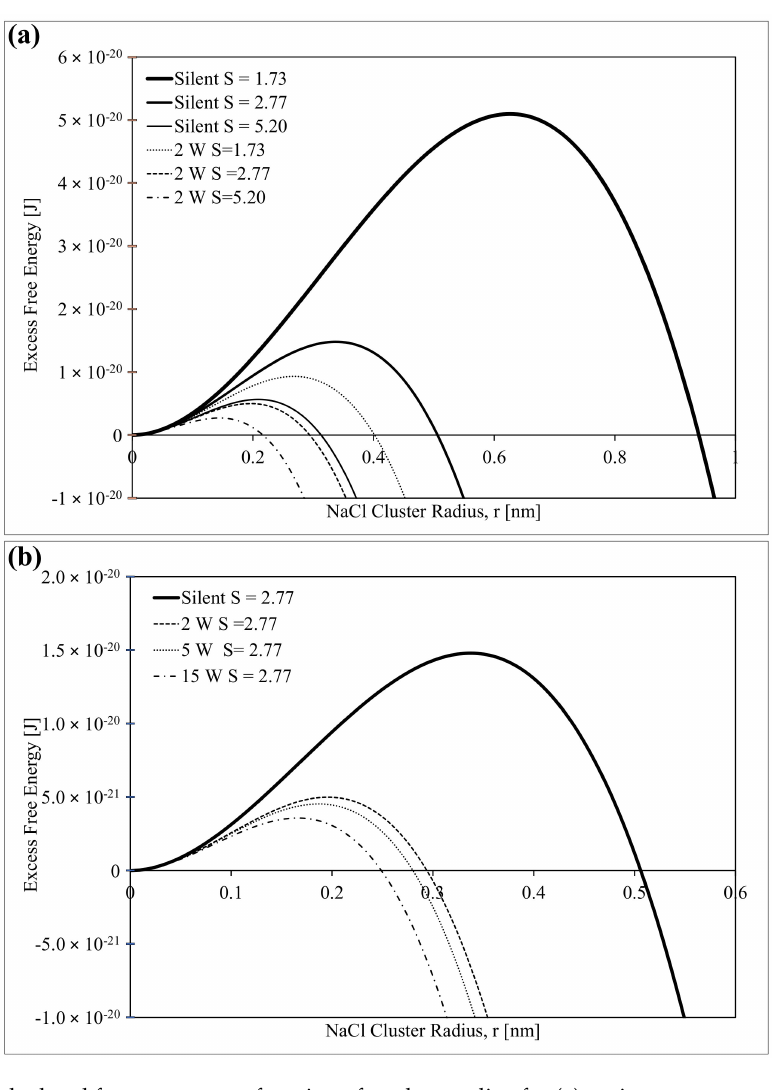
Figure 7. Calculated free energy as a function of nucleus radius for ( a ) various supersaturation ratios under silent and 2 W sonication, and ( b ) various sonication powers at a fixed supersaturation ratio.